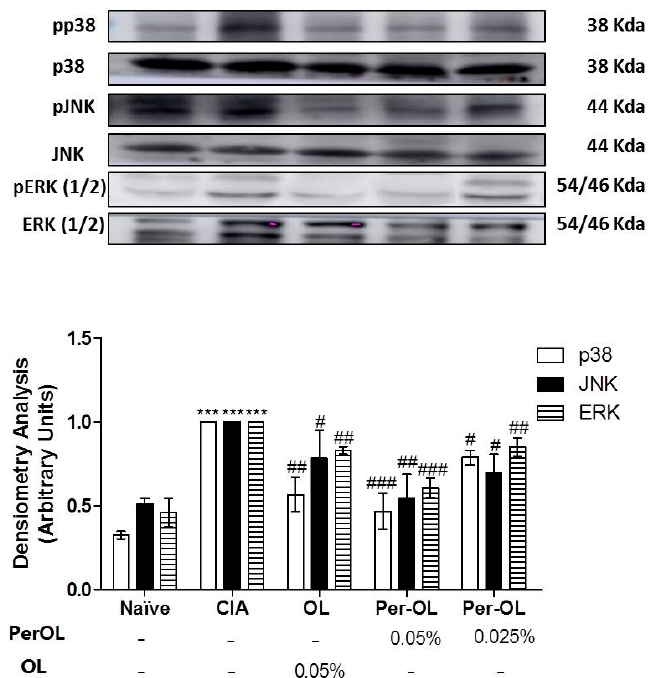
Figure 6. Effects of dietary OL and Per-OL on JNK, p38, and ERK (1/2) MAPKs phosphorylation in hind paws homogenate. The expression of phosphorylated proteins was expressed related to the expression of the corresponding total protein. The expression was quantified by densitometry analysis and normalized with respect to a specific total protein. Data represent mean ± S.E.M., n = 5. *** p < 0.001 vs. SD-Naïve control group, # p < 0.05, ## p < 0.01 and ### p < 0.001 vs. SD-CIA control group. Nutrients 2021 , 13 , x FOR PEER REVIEW